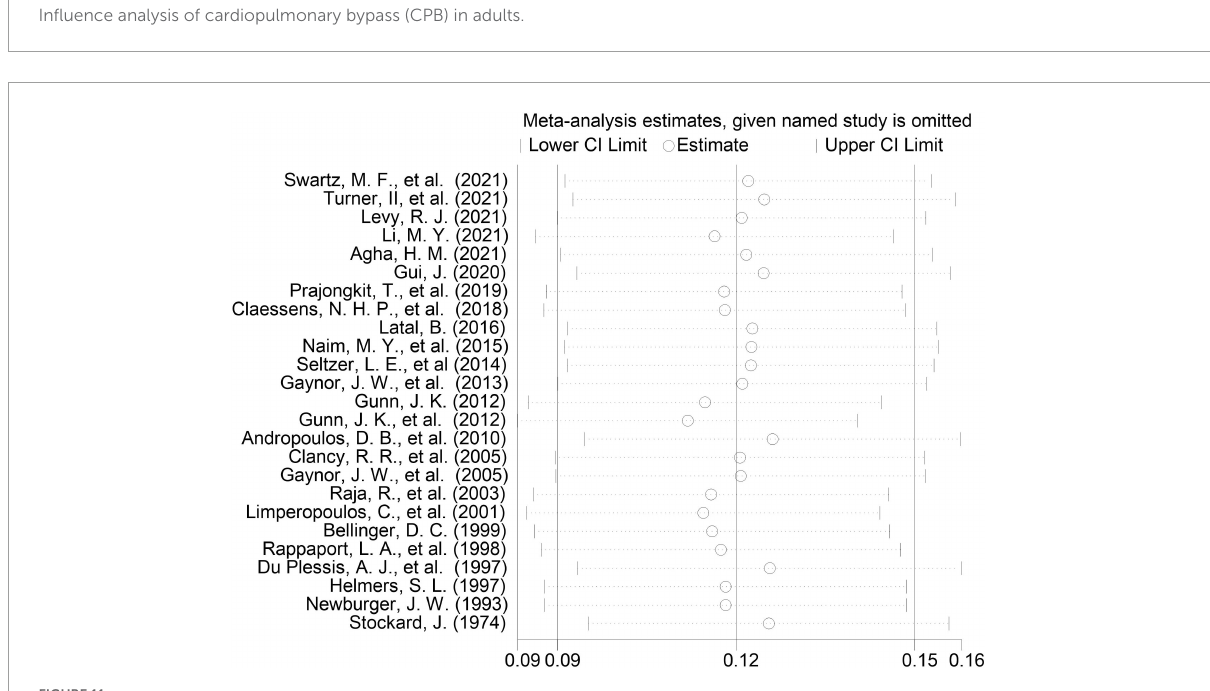
FIGURE11 Influence analysis of cardiopulmonary bypass (CPB) in